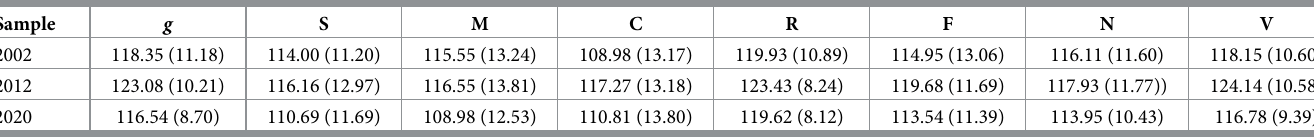
Table 5. Means (and SD ) of the different ability scores in Analysis 1b. Sample